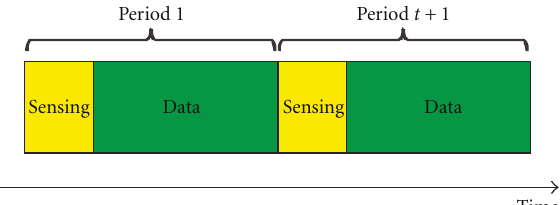
Figure 2: Timing structure of spectrum sensing and data transmis-